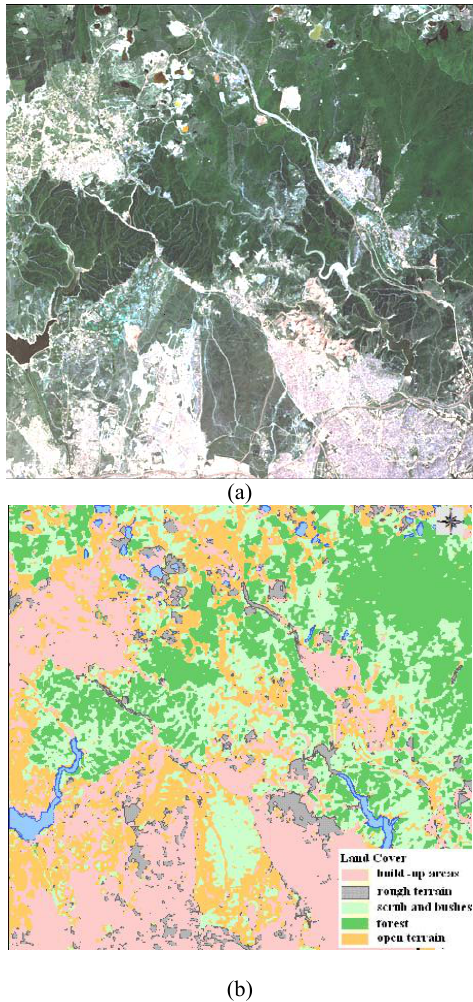
Figure 1. The test side in Istanbul (a) and land covers types